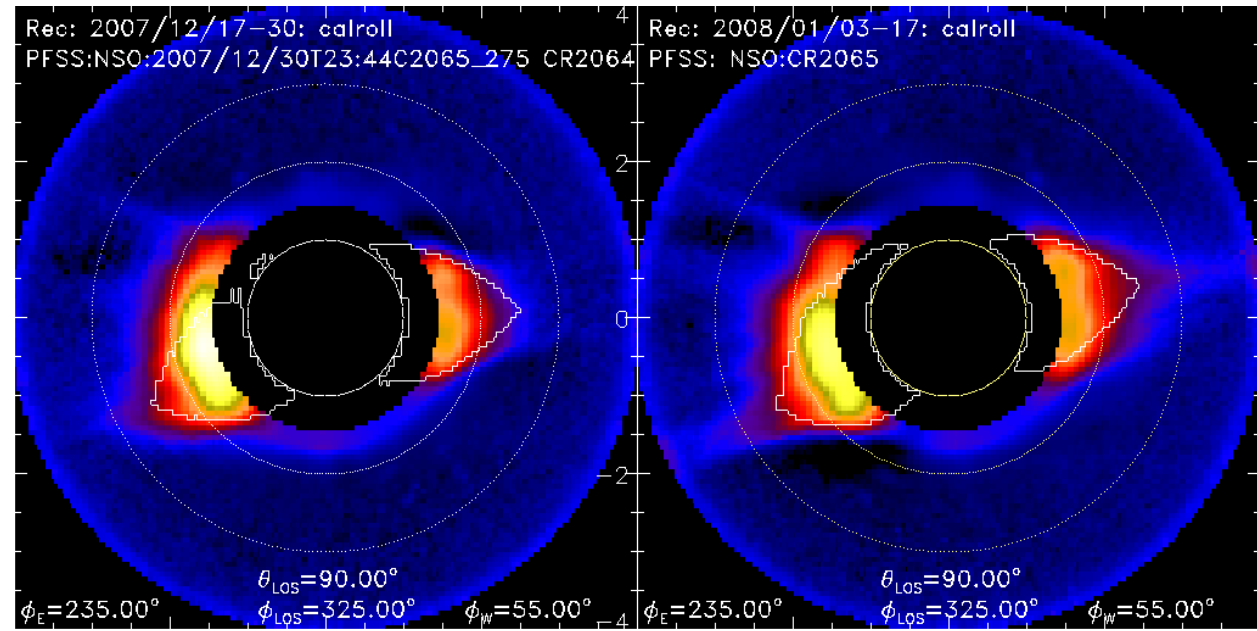
Fig. 6. Cross-sections of the reconstructed electron density in square root scale by a plane perpendicular to a LOS with Carrington longitude of 325 ◦ and colatidude of 90 ◦ . The reconstruction for the period before the CME2ab is shown on the left side while the reconstruction for the period after CME2ab is shown on the right side. The white contour lines are the boundaries between closed and open magnetic field lines for a PFSS model with source surface at 2 . 5 R ⊙ for CR 2064 and CR 2065, i.e. periods approximately before and after the CME. The white circles mark heliospheric distances for 1 , 2 and 3 R ⊙ .